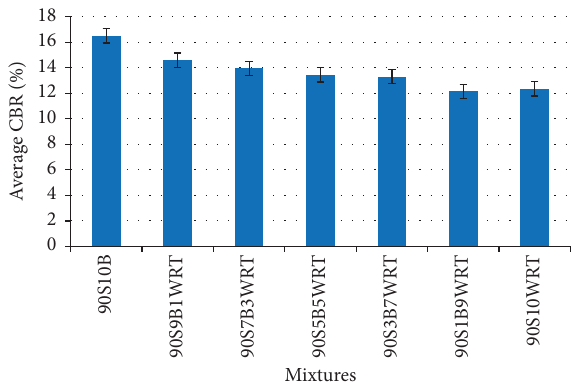
Figure 8: CBR values of all mixture.